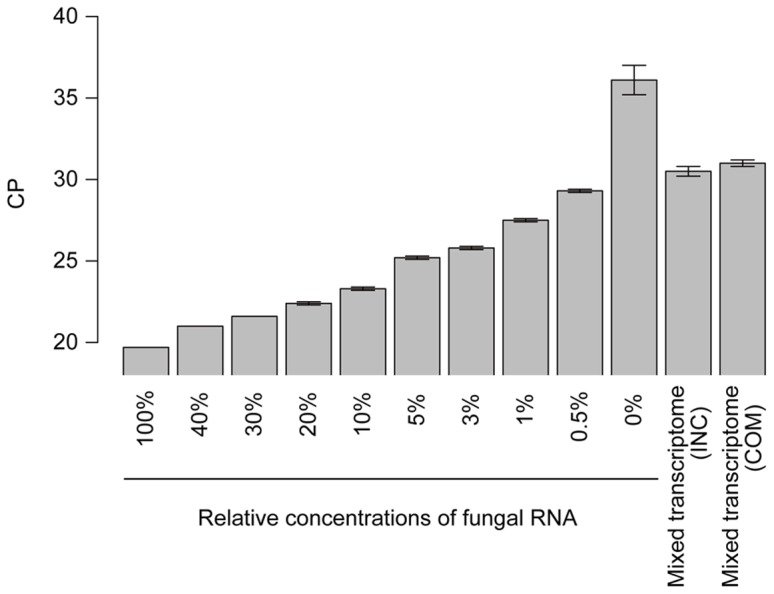
quantitative Real-Time RT-PCR experiments to assess fungal RNA contents in mixed transcriptome samples.The presence of fungal RNA in the mixed transcriptome samples (COM: compatible, INC: incompatible interactions) was examined by qRT-PCR using artificial mixed transcriptome samples at several fungal RNA concentrations (0, 0.5, 1, 3, 5, 10, 20, 30, 40 and 100%). Crossing point (CP) values represent the point at which the amount of the amplified fungal actin reached a fixed threshold. High CP values indicate low abundance of fungal RNAs. The means and standard errors of CP values of three technical replicates are shown for each sample.